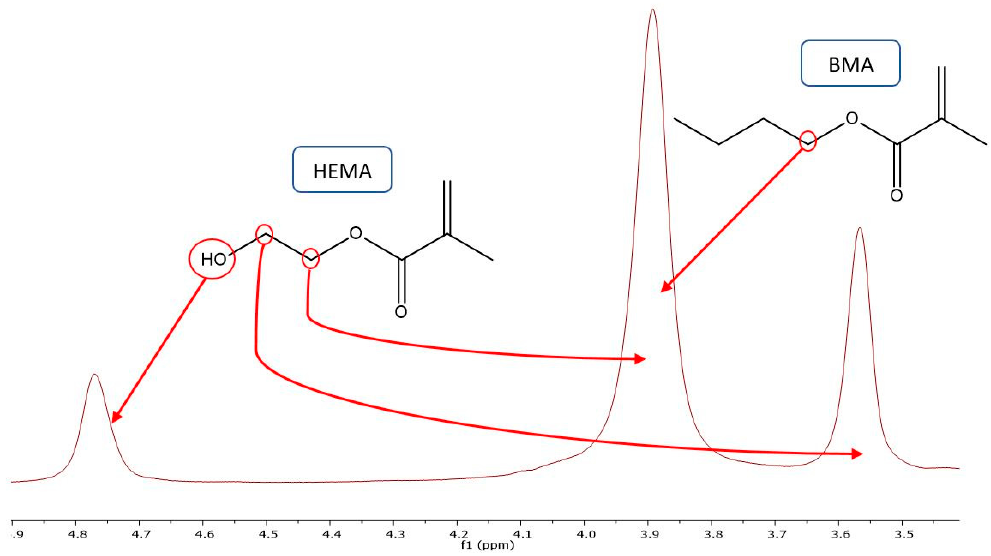
Figure 1. Expanded proton nuclear magnetic resonance (NMR) spectrum showing peaks used for determination of butyl methacrylate (BMA)/2-hydroxyethyl methacrylate (HEMA) copolymer composition.